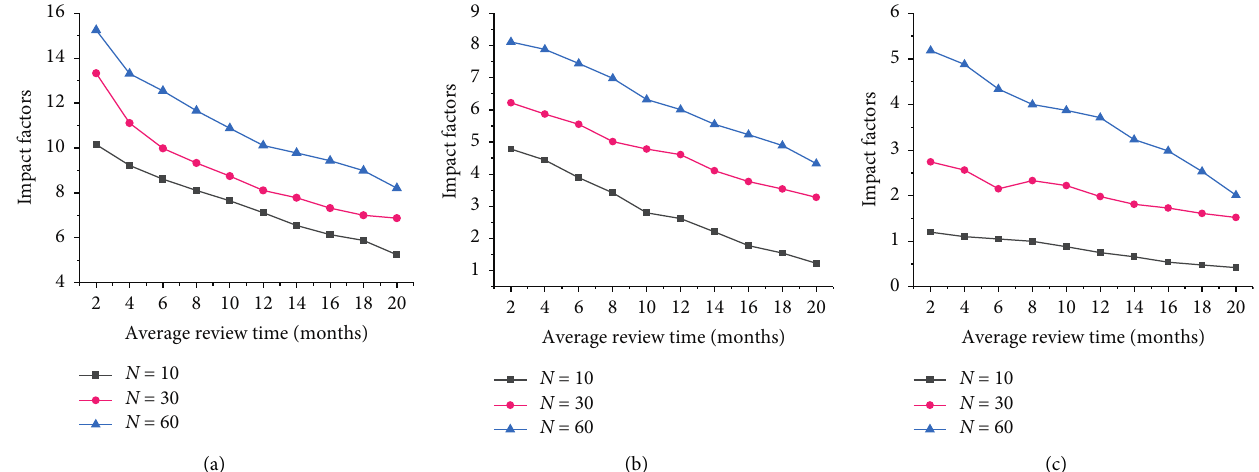
Figure 10: Correlation between impact factors and T and N for univariate sensitivity analysis: (a) α � 40, β � 10, and c (b) α ( ( baseline ) baseline )